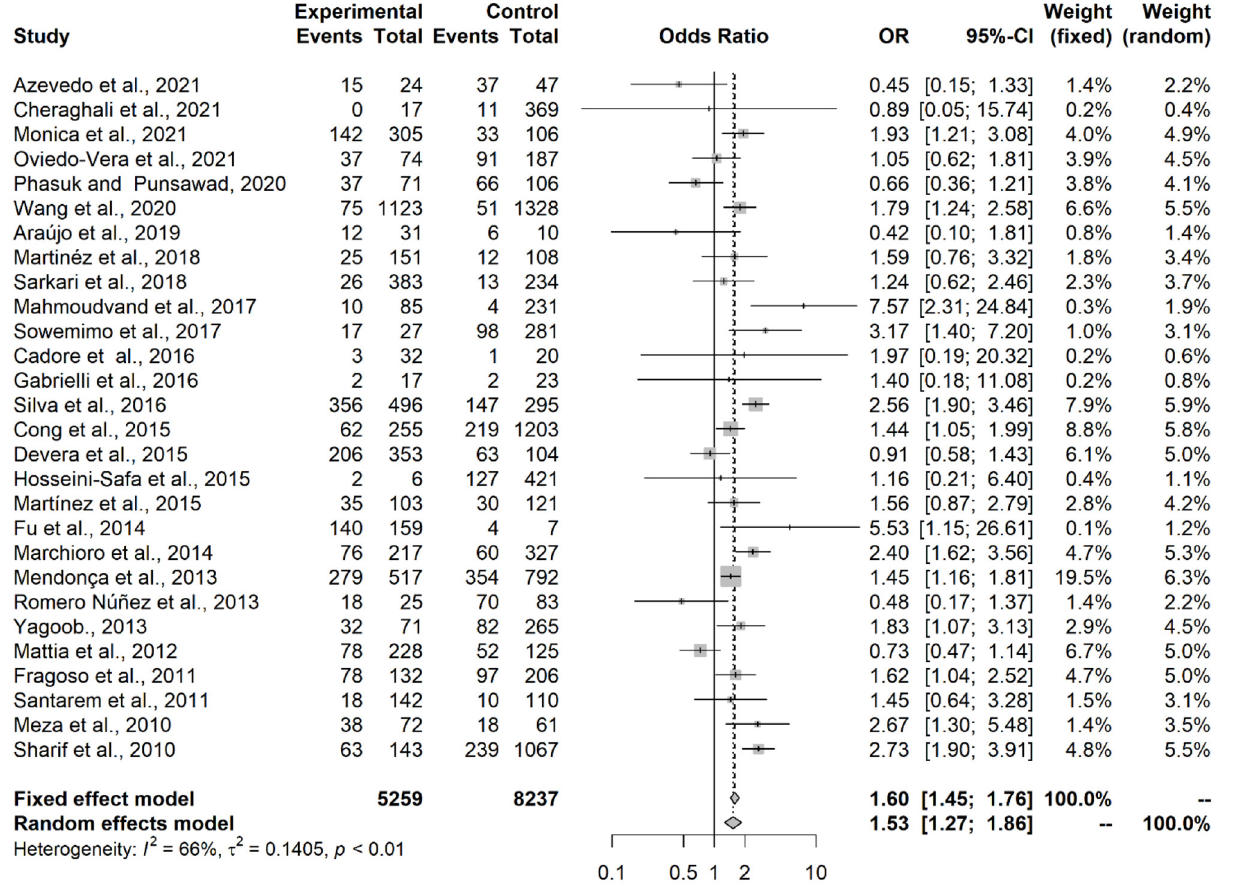
Frontiers in Public Health |